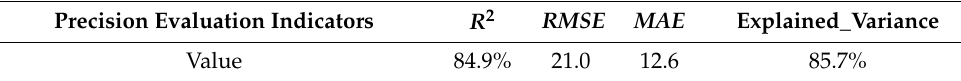
Table 4. Evaluation indicators. R 2 is the degree of model fit; RMSE is the root ‐ mean ‐ square error; MAE is the mean absolute error; explained variance is the degree of explanation of the model. Precision Evaluation Indicators